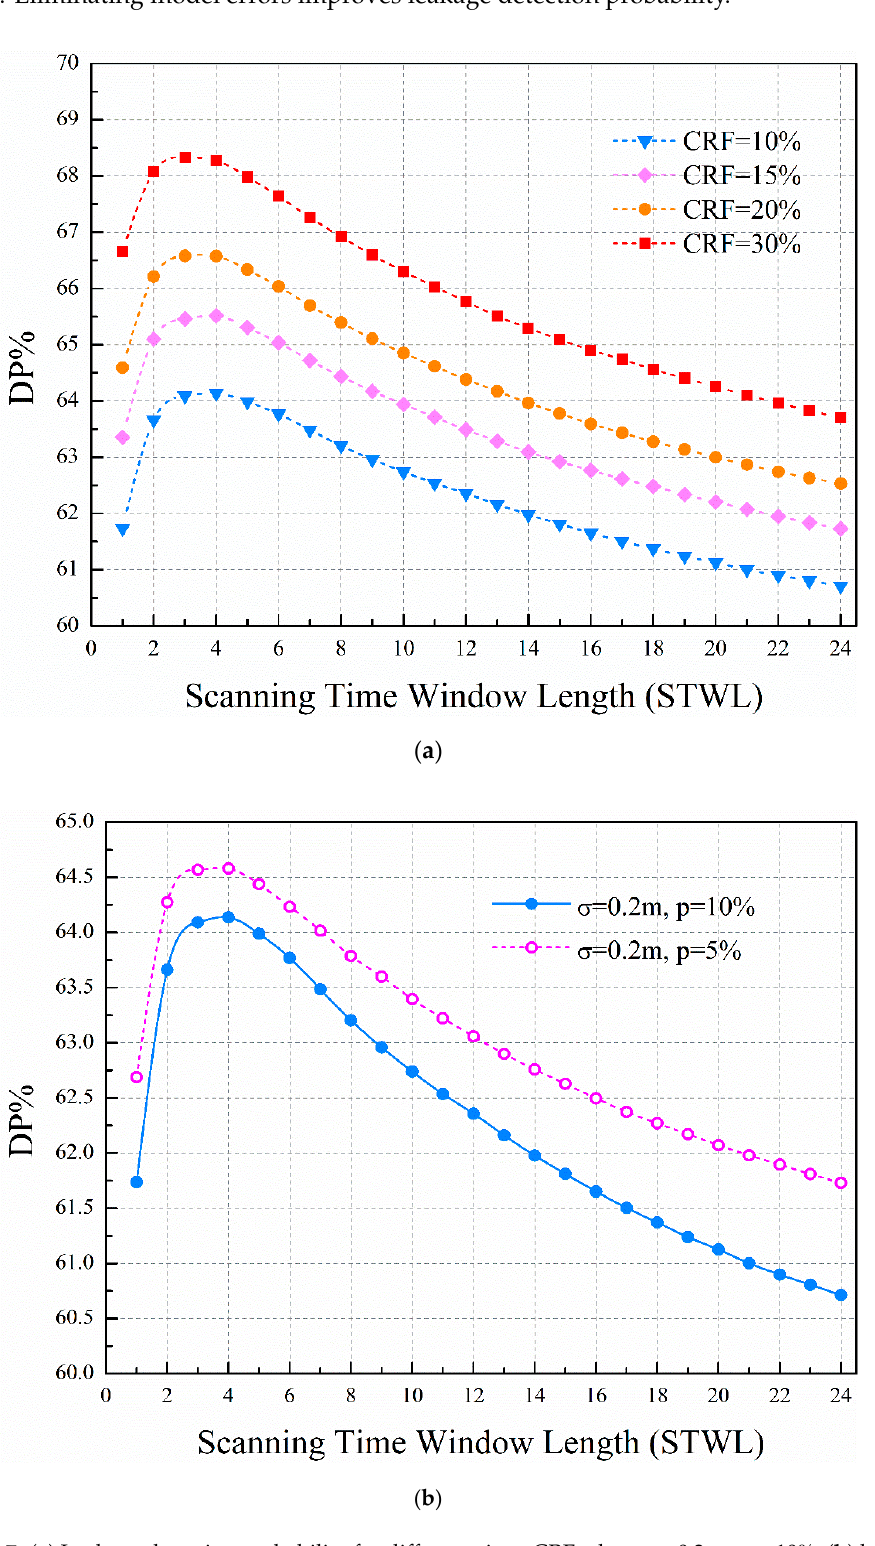
Figure 7. ( a ) Leakage detection probability for different given CRF when σ = 0.2 m, 𝑝 = 10%; ( b ) leakage detection probability for different tested data sets when CRF = 10%.